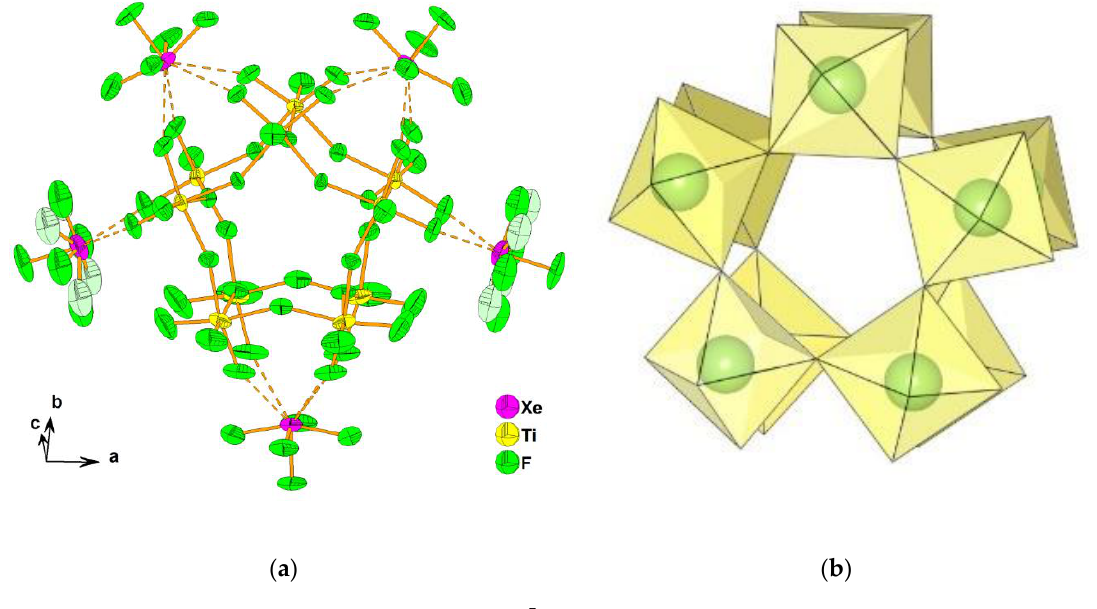
Figure 5. ( a ) [XeF 5 ] + cations and [Ti 10 F 45 ] 5– anions, composed of ten TiF 6 octahedra, in β-[XeF 5 ] 5 [Ti 10 F 45 ]. Ref. [35]; reproduced by permission of The Royal Society of Chemistry (RSC) on behalf of the Centre National de la Recherche Scientifique (CNRS) and the RSC; ( b ) Geometry of the [Ti 10 F 45 ] 5– anion β -[XeF 5 ] 5 [Ti 10 F 45 ]